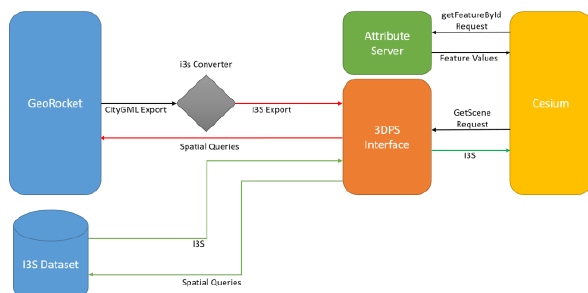
Figure 6. This image shows two dataflows: 1: The supposed dataflow (in red) from GeoRocket which exports CityGml,